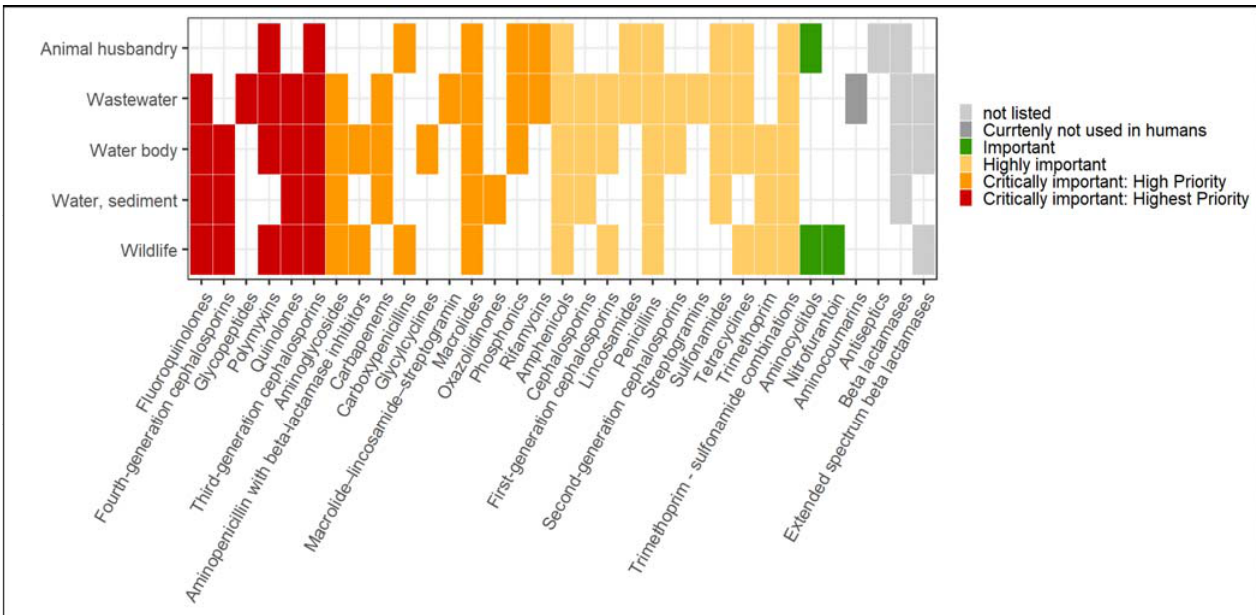
Figure 2. Overview of the occurrence of resistance to antibiotic classes reported in the included studies across the environmental sectors. The “Water, sediment” category also includes soil. The color profile represents the WHO CIA list categories. Notes: ARGs reported in the studies were not assumed to cause the phenotypic antibiotic resistance but rather the resistance potentially associated with the ARGs. Table S8 in Supplementary Materials presents the data.